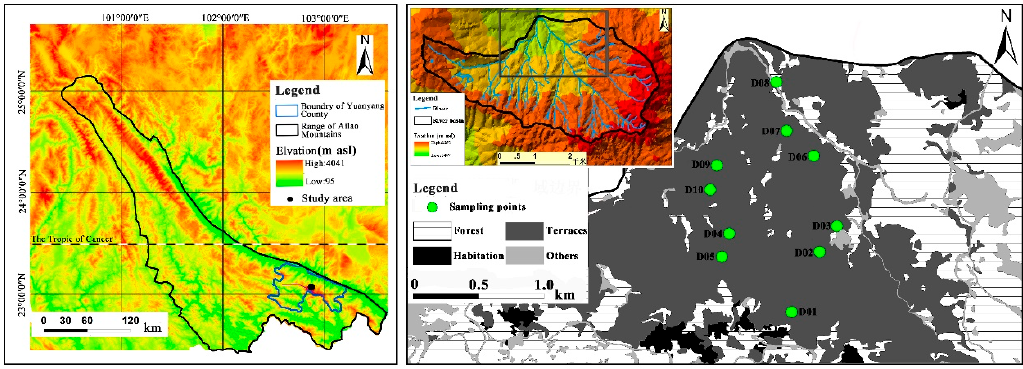
Figure 1. Study area and distribution of sampling points.